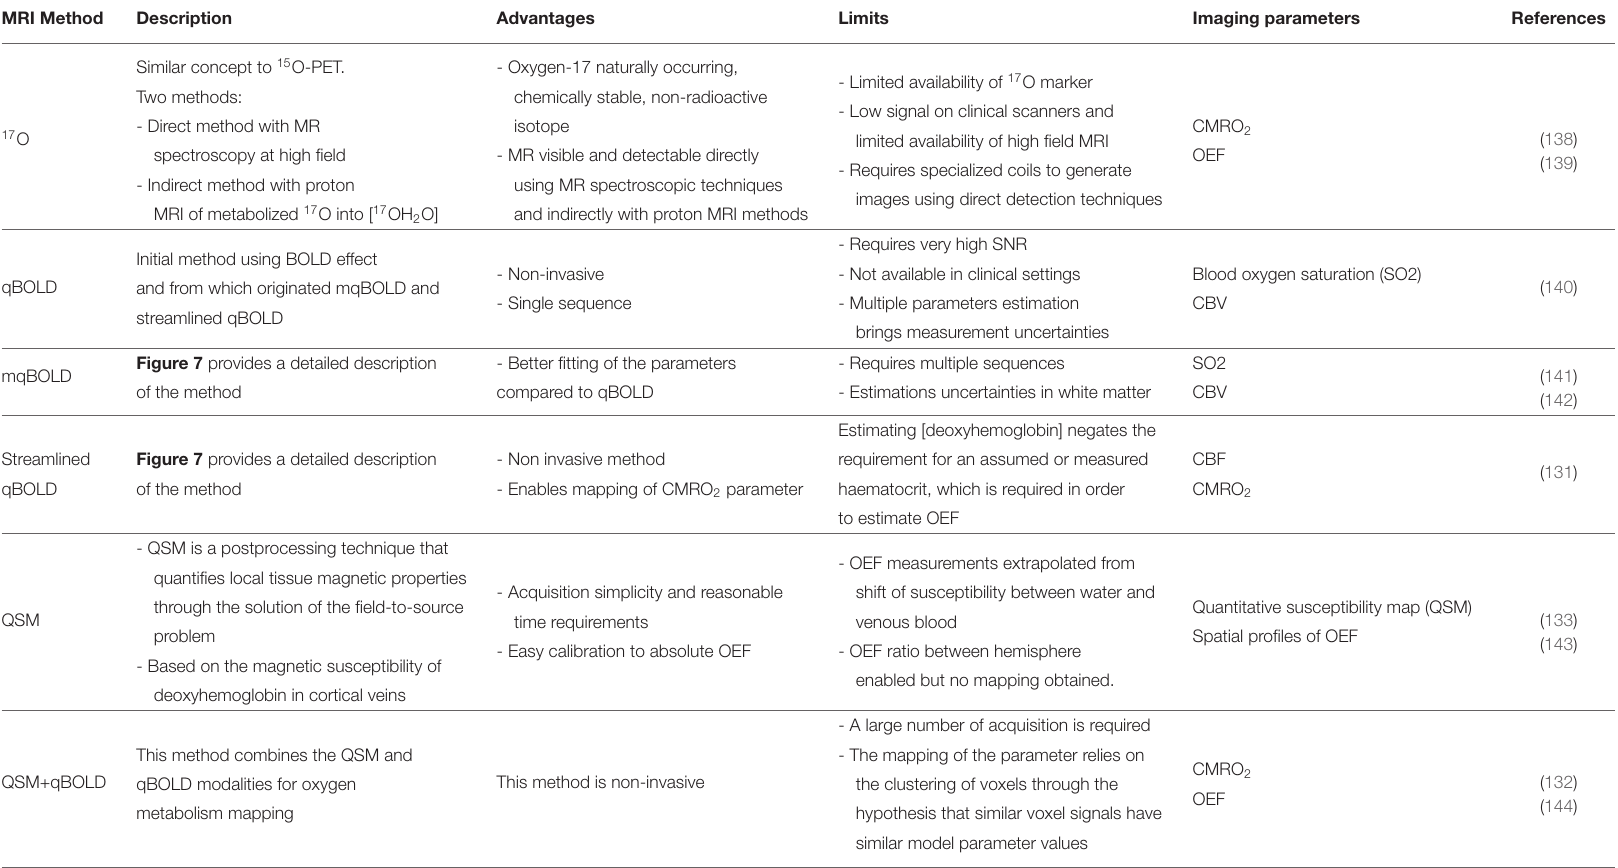
TABLE 1 | Overview of MRI metabolic penumbra imaging